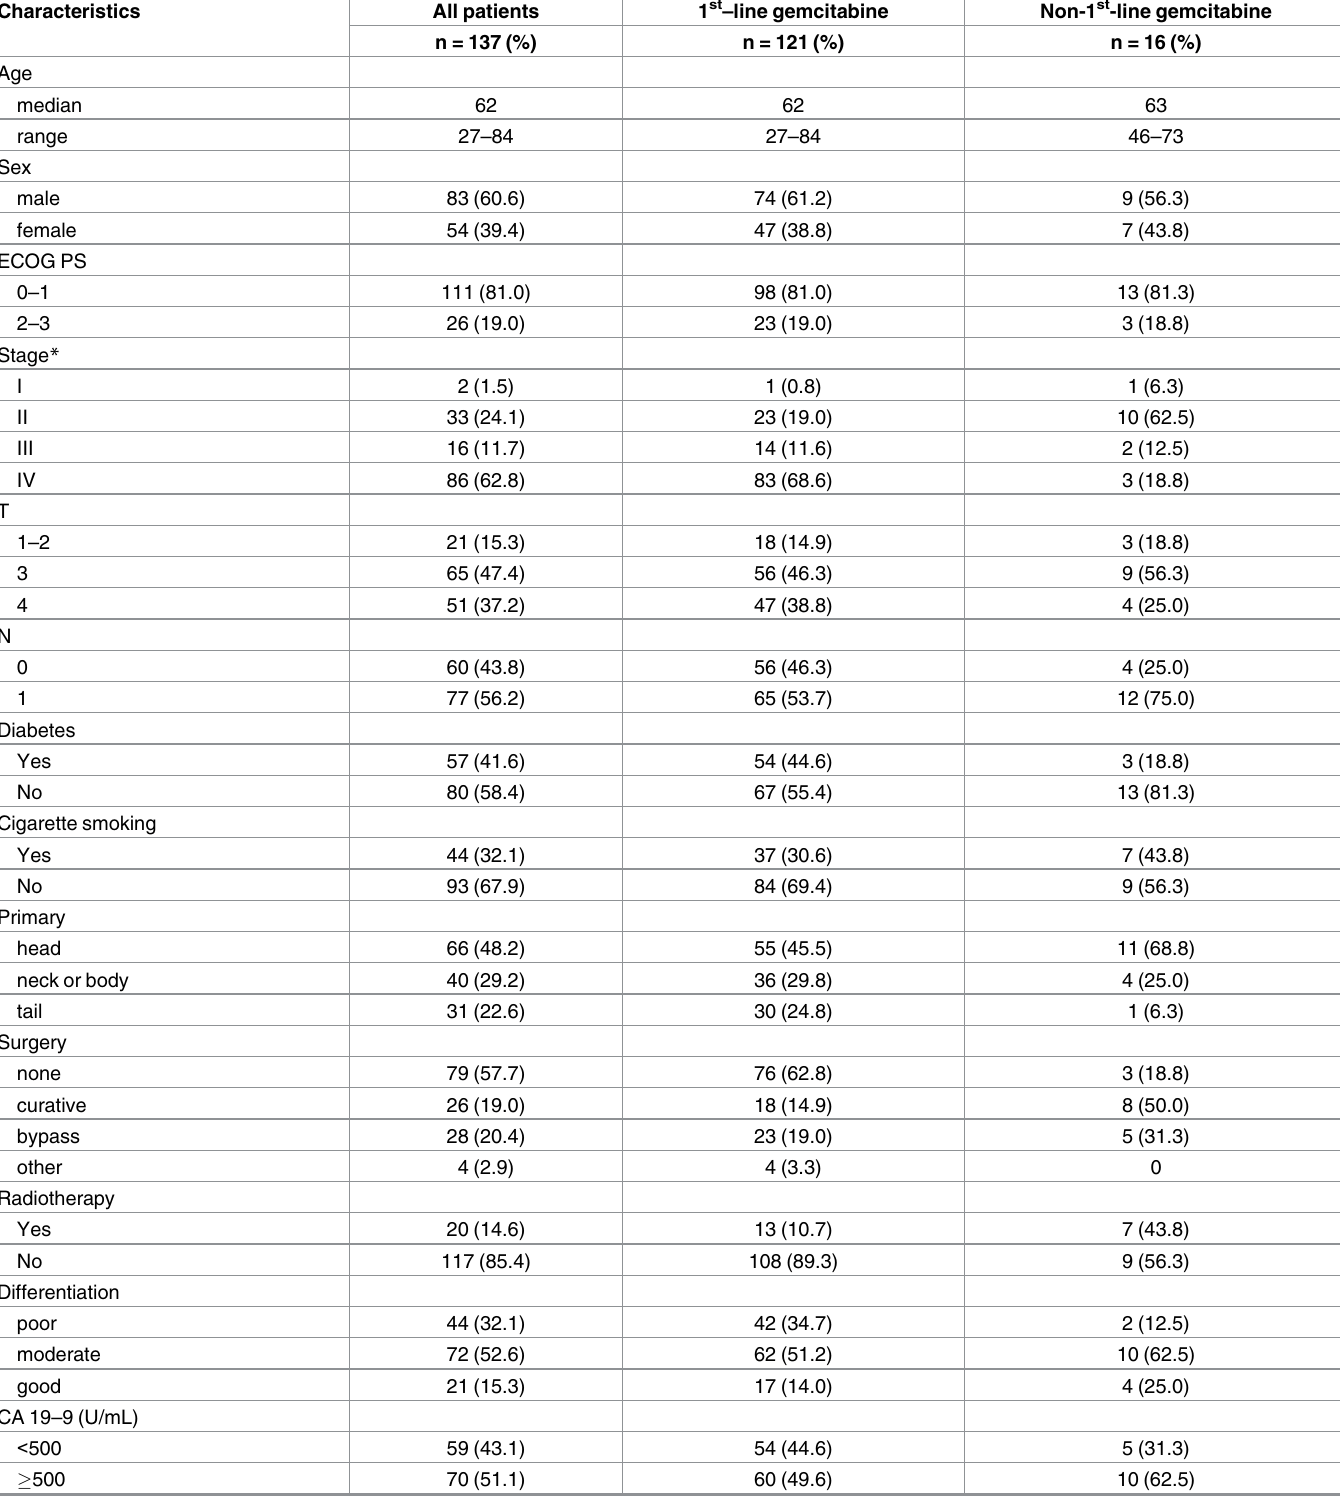
Table 1. Patient